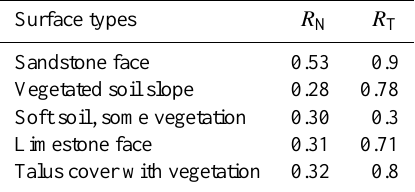
Table 1. Coefficient restitution of surface type. Surface